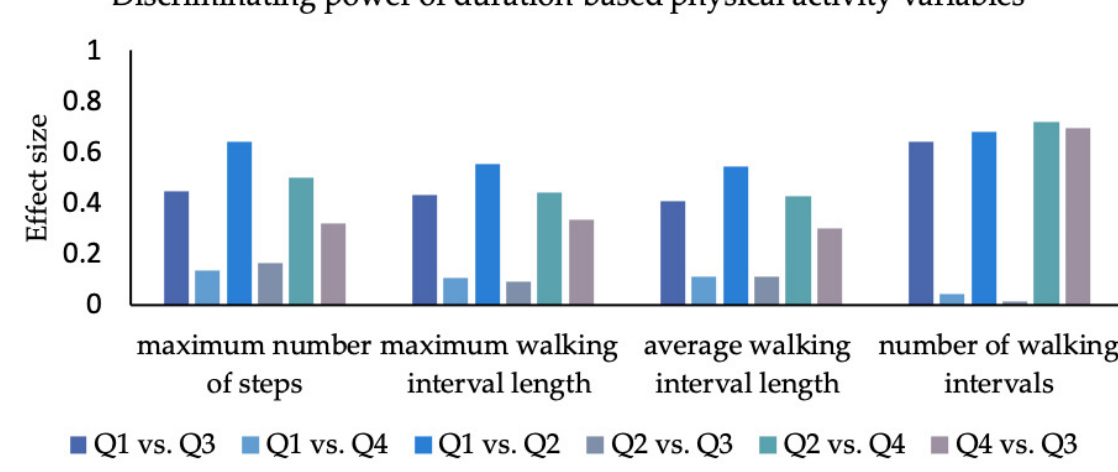
Figure 3. The effect size for each group comparison for duration-based PA variables. Q1: 1. quadrant